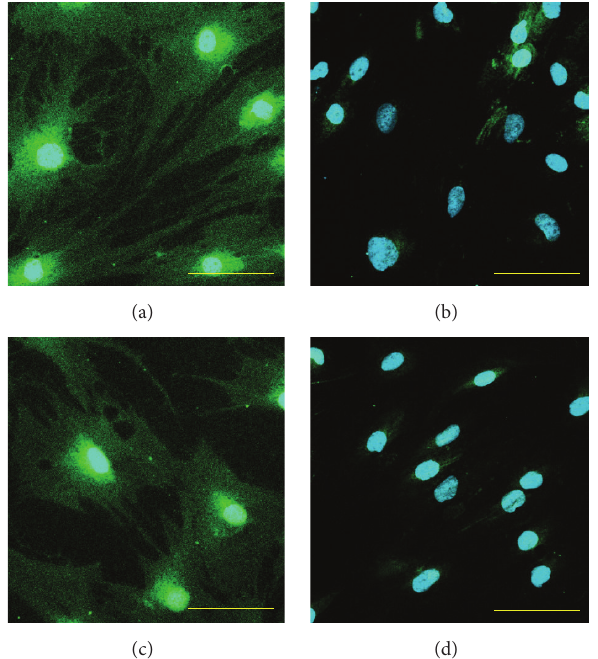
Figure 28: Immunofluorescence staining of CD117 and PROM1. Immunofluorescence staining of CD117 (a) and of PROM1 (c) of the cell line of OSA3-CSCs. (b and d) Negative controls, respectively, for each marker. LSCM in conventional colors: green for ESCs and sky blue for nuclei. Original magnifications: 20x. Bar size: 100 𝜇